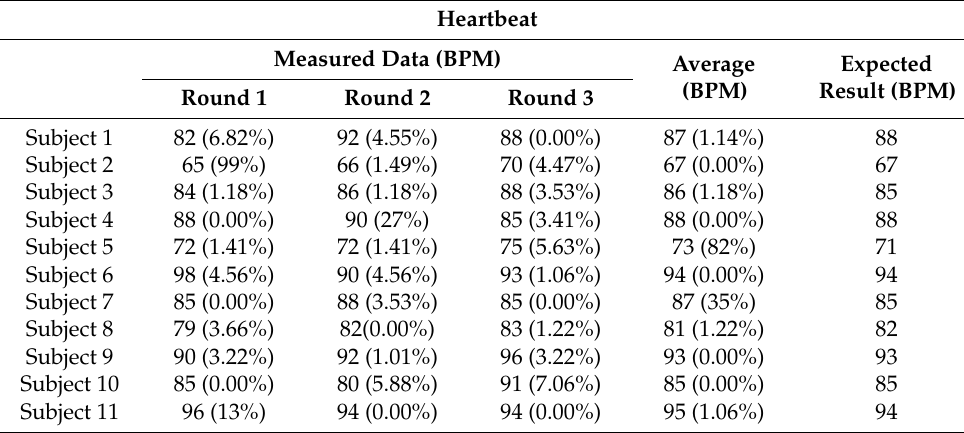
Table 8. Heartbeat measured data and expected result.